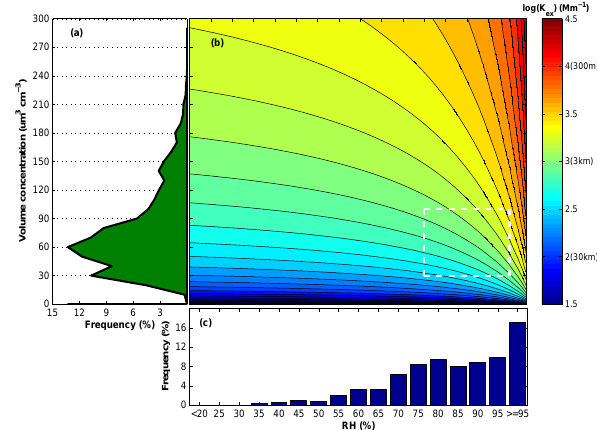
Fig. 4. (b) Calculated K ex at given aerosol volume concentrations and RH at logarithmic scale; the crossed aera in white dashed line box represents the most common aerosol pollution and humidity state with the largest frequency distributions of aerosol volume con- centration and RH; (a) and (c) Frequency distributions of measured aerosol volume concentrations and RH,